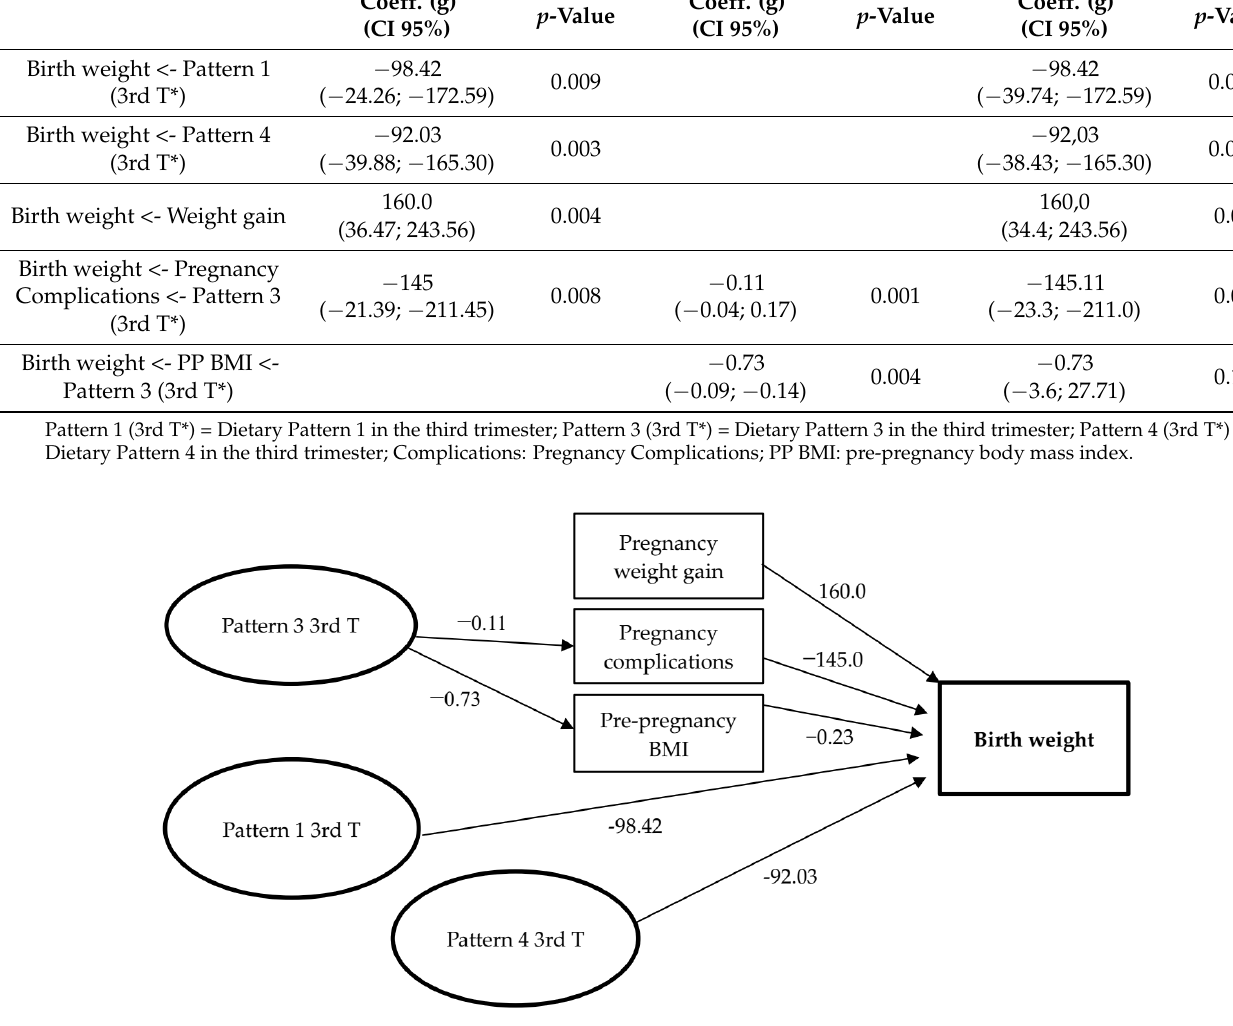
Figure 3. Structural equation modelling of the relationship between dietary patterns in pregnancy on birth weight. Cohort NISAMI. Santo Antônio de Jesus, Bahia, April 2012 and June 2013. Pattern 1 3rd T = Dietary Pattern 1 in the third trimester; Pattern 3 3rd T = Dietary Pattern 3 in the third trimester; Pattern 4 3rd T = Dietary Pattern 4 in the third trimester; Pregnancy Complications: (anaemia, urinary tract infection, gestational diabetes, hypertensive disorders); PP BMI: pre-pregnancy body mass index. Table 3. Modelling of the structural equations to observe the direct and indirect effects between birth weight, maternal variables and dietary consumption patterns, Santo Antônio de Jesus, Bahia, Brazil, 2012–2013.